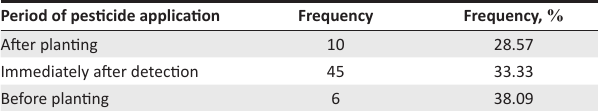
TABLE 3: Period of pesticide application.